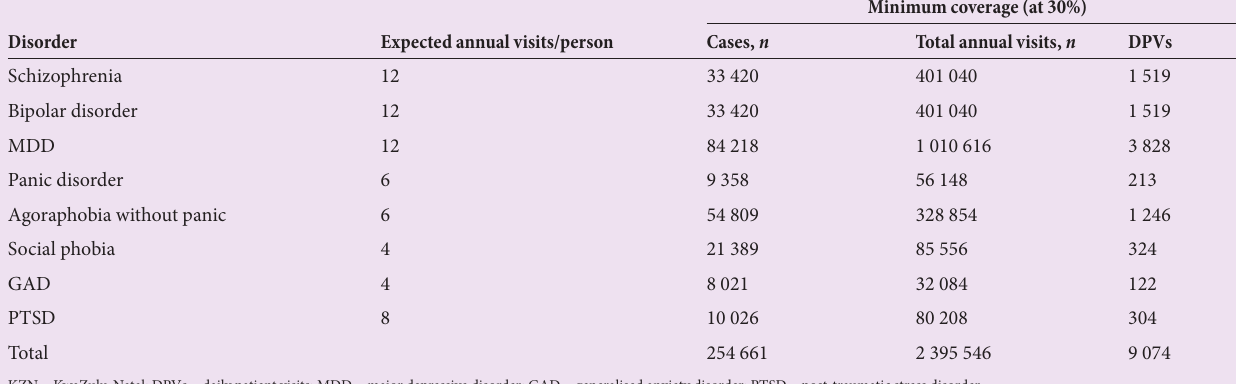
Table 5. Annual and daily patient visits required for ambulatory mental healthcare in KZN